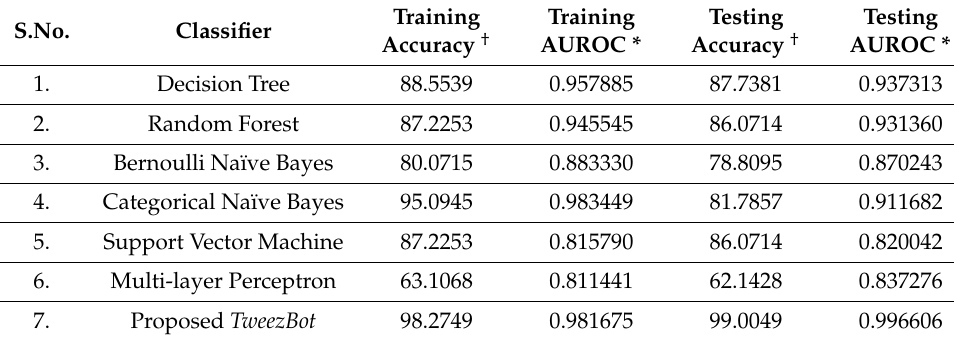
Figure 17. Comparative Analysis of Accuracy for Various Classifiers while Testing. Table 3. Accuracy of Machine Learning Classifiers & Proposed TweezBot